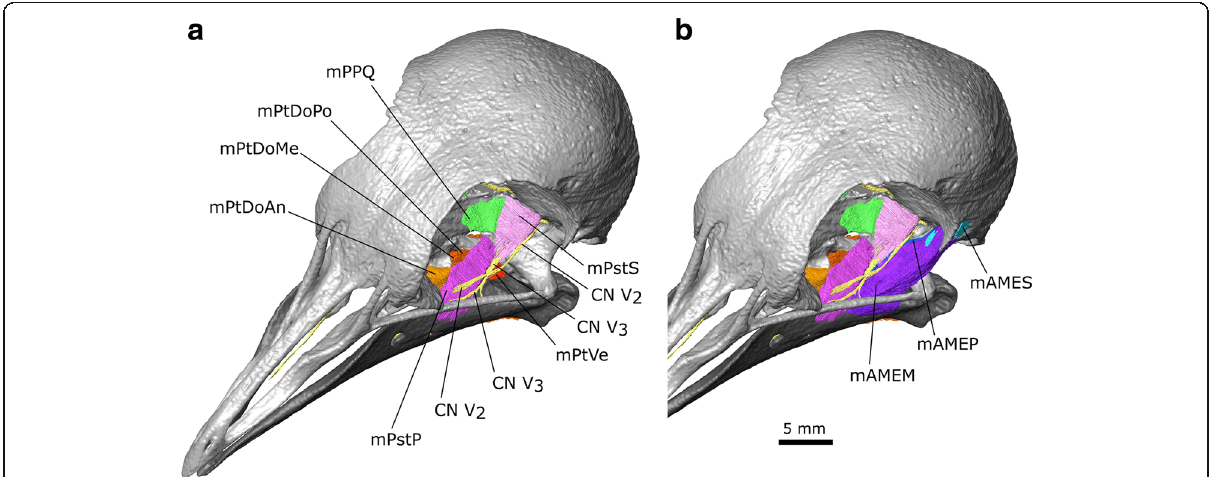
Fig. 6 The digital dissection of the left adductor chamber of Columba livia showing the location of the adductor muscles relative to the trigeminal nerve (CN V). a the external adductor muscles absent b the external adductor muscles